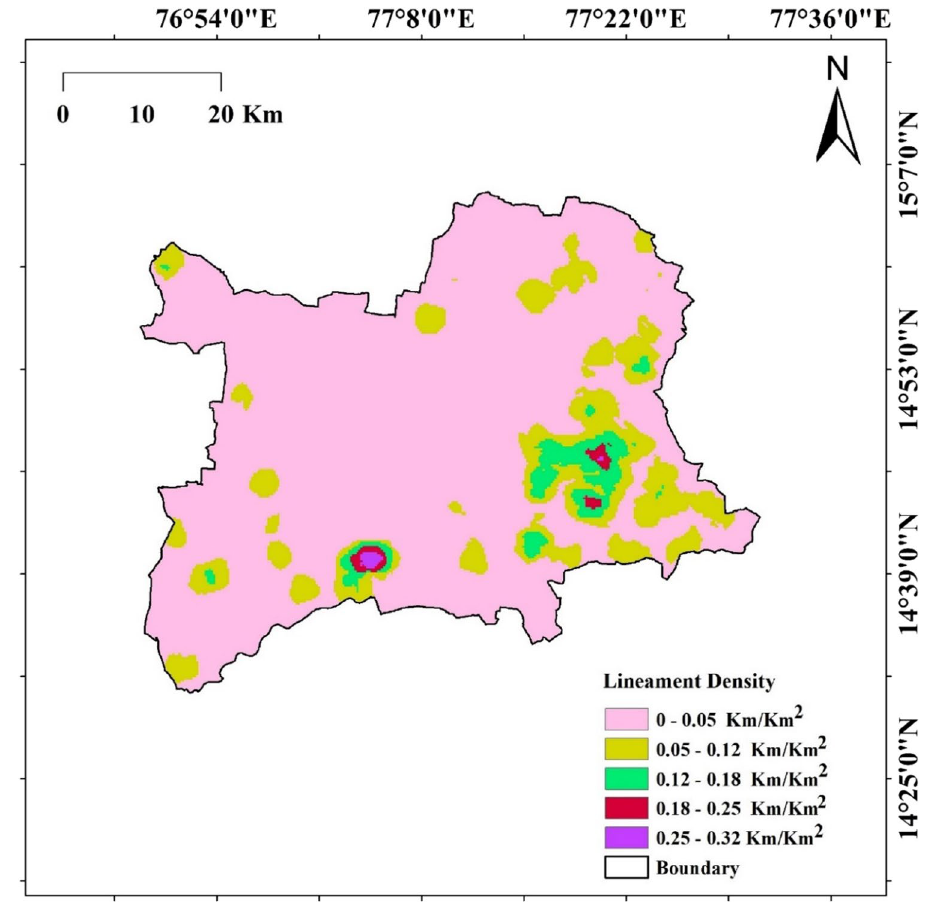
Fig. 9 Lineament